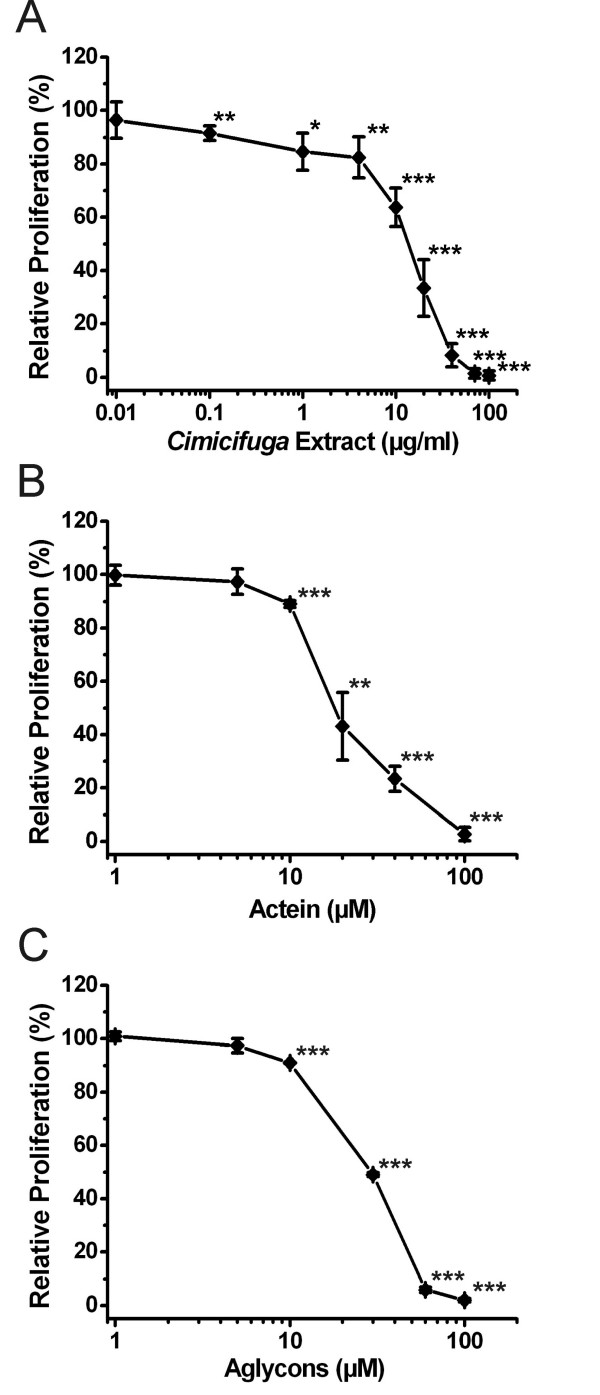
Proliferation assay: Effects on growth rate of MCF-7 cells. MCF-7 cells were treated with (A) dichloromethane extract of black cohosh rhizome, (B) actein or (C) mixture of aglycons derived from cycloartane glycosides. Controls (100% proliferation) contained 0.1% DMSO. After 120 h cell number was determined by MTT dye-reduction assay. Relative proliferation data are presented as means ± SD (n = 3–6). *p < 0.05, **p < 0.01, ***p < 0.001 vs. control (Student's t-test).